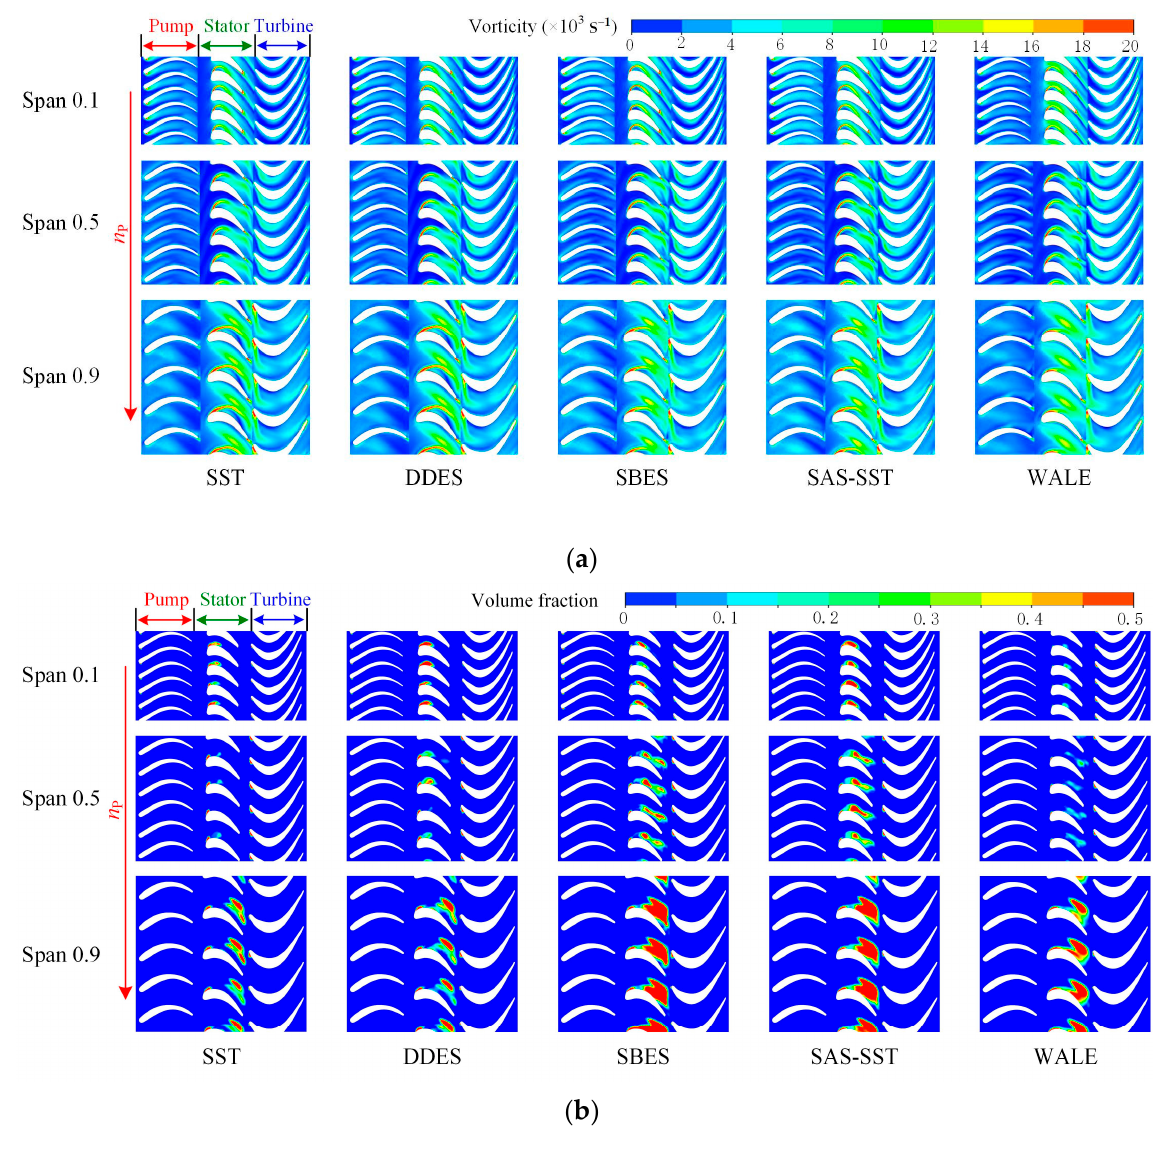
Figure 15. Vortex and vapor volume fractions of three span surfaces. ( a ) Vortex distribution of span surfaces; ( b ) Vapor volume fractions of span surfaces.